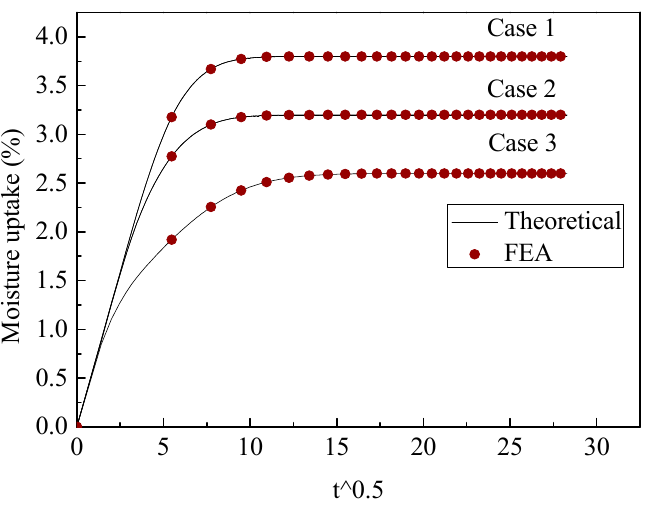
Figure 5. Validation of three-phase diffusion model, D 1 ( 0.005 ) < D 2 ( 0.02 ) , C 1 ( 0.5 ) < C 2 ( 1 ) .